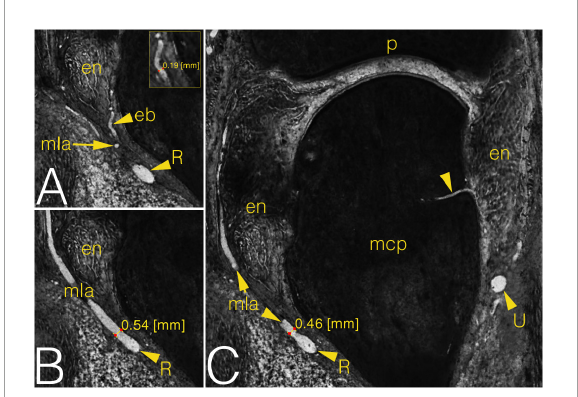
FIGURE6 Grayscale images of a cryosectioned right MCP2 joint demonstrating joint anatomy and measurement on the arteries in coronal plane. (A) Corresponds to the left inferior quadrant of panel (C) , level of cryosectioning 13 layers (0.65 mm) palmar. Insert shows diameter measurement on enthesial branch. (B) Corresponds to the left inferior quadrant of panel (C) , level of cryosectioning 9 layers (0.45 mm) dorsal. (C) Metacarpal part of the joint with an ulnar enosseal branch. Note the difference between the diameter values of the same radial main lateral artery depending on measurement’s localization. arrowhead, enosseal branch; eb, enthesial branch; en, enthesis; mcp, metacarpal; mla, main lateral artery; p, phalanx; R, R-branch; U,